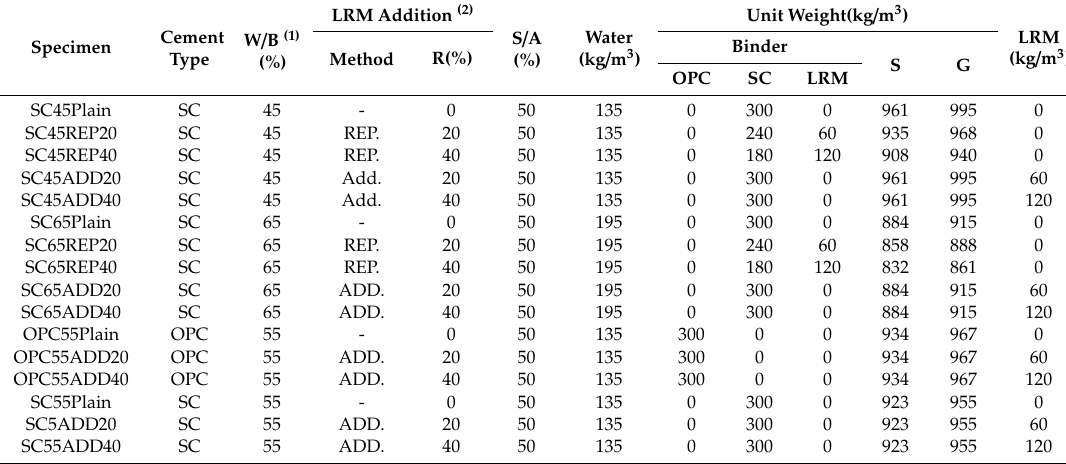
Table 6. Experimental plan and concrete mixture proportion.